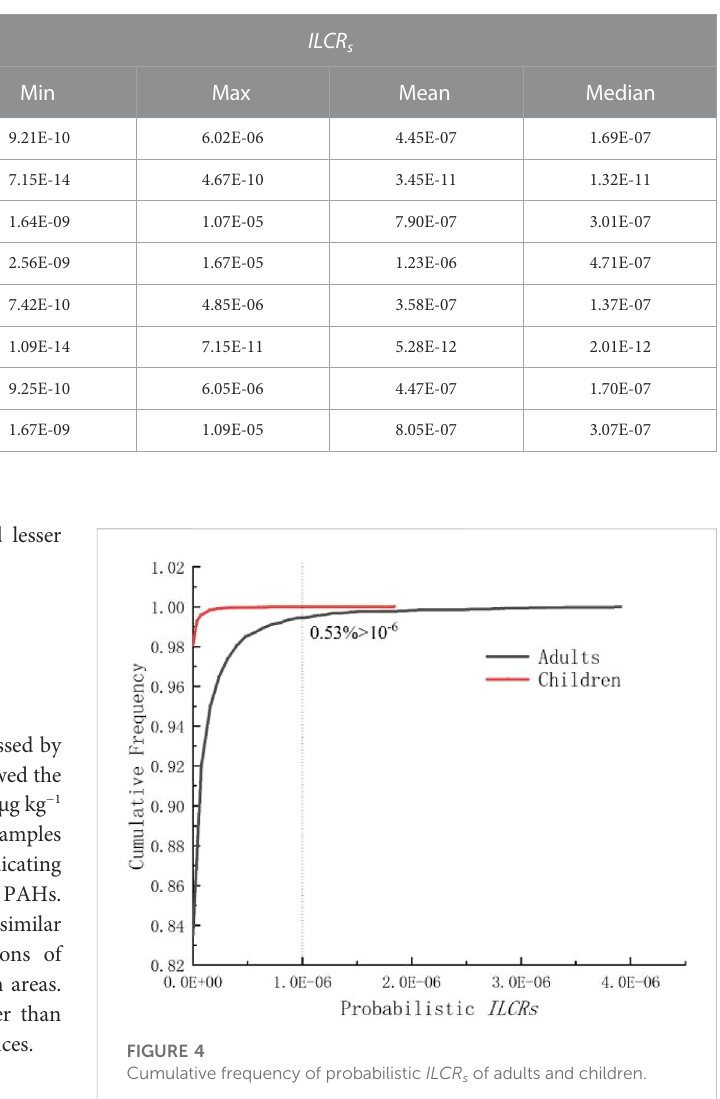
TABLE 2 The ILCRs for adults and children via three exposure routes.